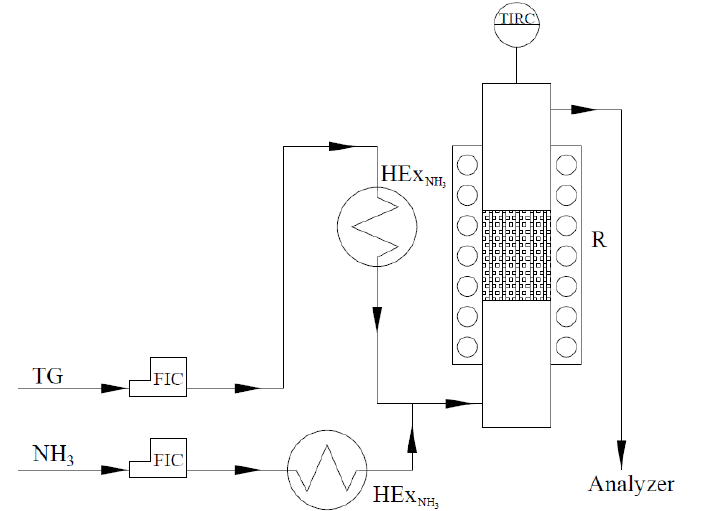
Figure 13. The scheme of the laboratory installation for NH 3 -SCR catalytic tests performed over Fe-Clin-I.